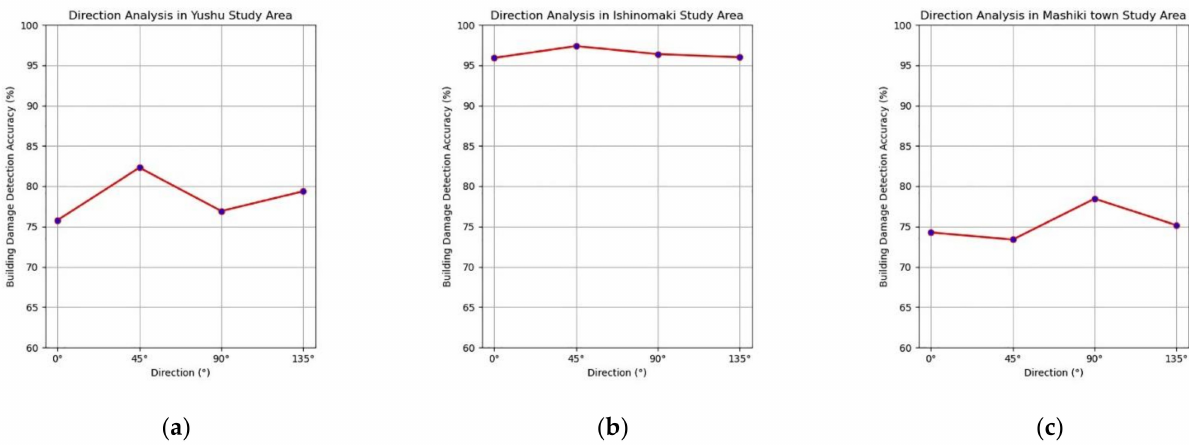
Figure 33. Overall accuracy (%) of building damage detection when using different directions to calculate texture features: ( a ) the results in the Yushu study site; ( b ) the results in the Ishinomaki study site; ( c ) the results in the Mashiki town study